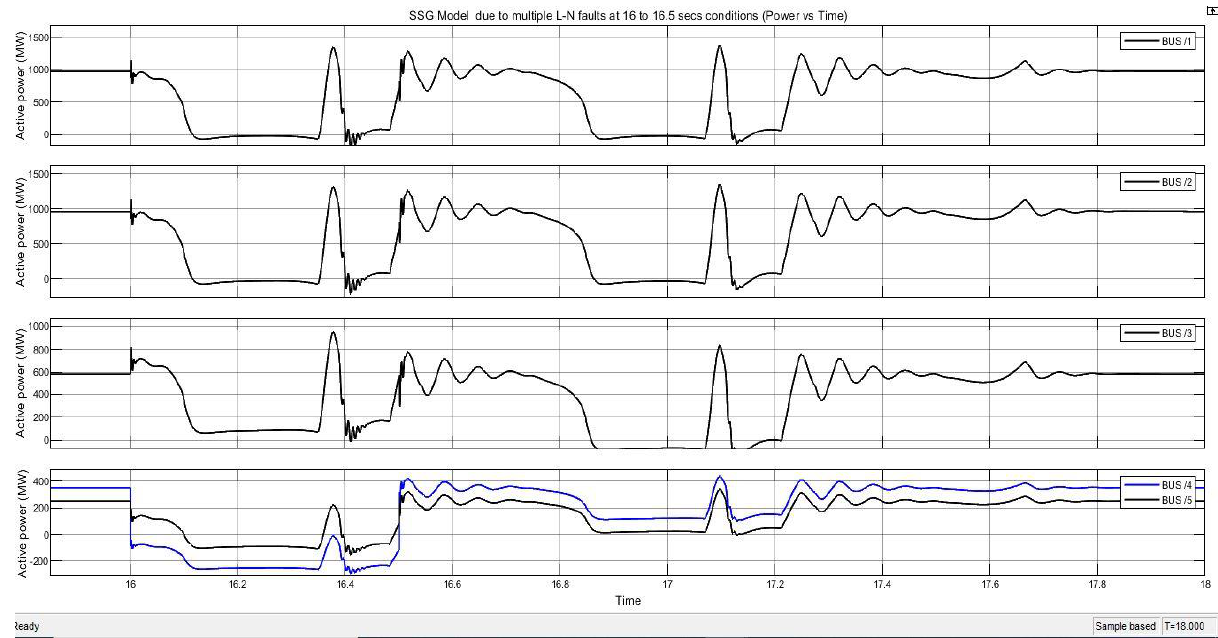
Figure 19. Multiple line-to-ground faults are inserted in the system from 16 to 16.5 s (Bus 1 to Bus 5).